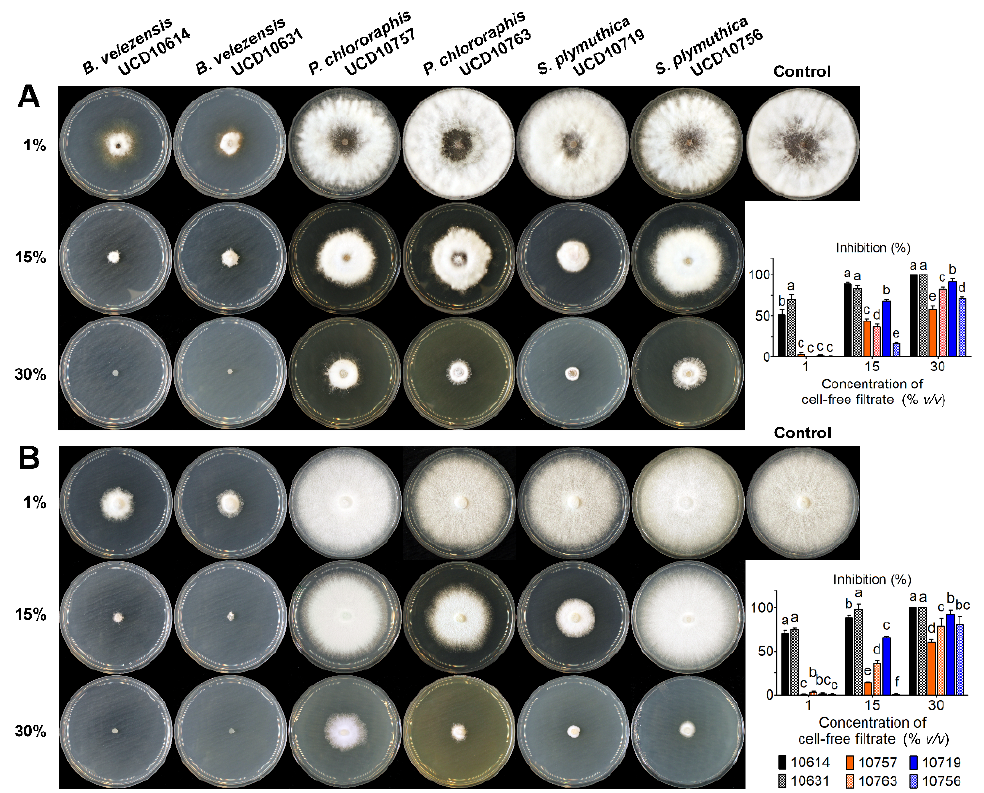
Figure 7. Inhibition levels (%) of increasing concentrations of agar-diffusible metabolites produced by selected bacterial isolates against the mycelial growth of N. parvum ( A ) and E. lata ( B ). On each graph, means with the same letter within each level of filtrate concentration are not significantly different from each other according to the Fisher’s LSD test ( p > 0.05). The legend at the bottom right shows isolate codes for both graphs.